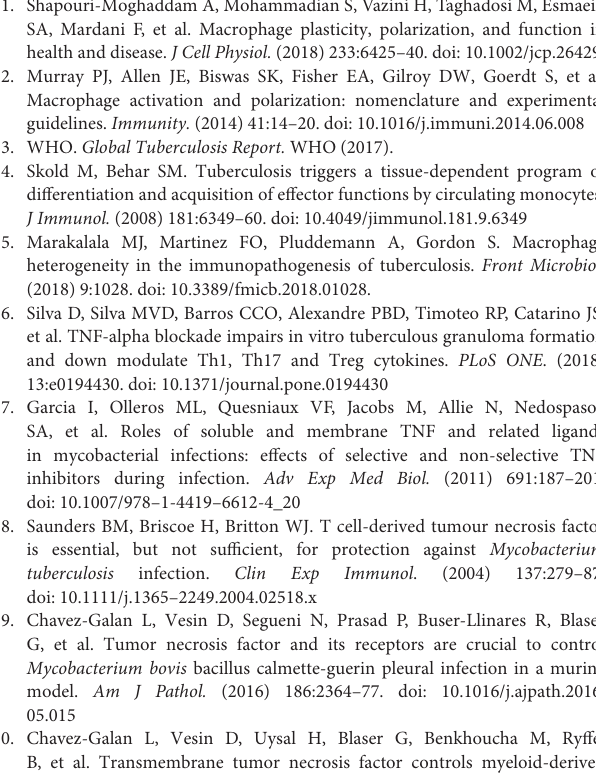
cytometry, using the Agilent RNA 6000 Pico kit, and the RNA integrity number (RIN) was obtained using an Agilent bioanalyzer to extract an algorithm that describes RNA integrity. RIN was obtained from human MDM before sorting (total MDM) (A) , and after sorting in CD3 + TCR αβ − MDM (B) and CD3 + TCR αβ + MDM (C) . The RIN value is squared in blue. The data are representative of three independent donors. Figure S3 | Analysis strategy to evaluate TNF-receptors on CD3 + CD11b + TCR αβ − and CD3 + CD11b + TCR αβ + cells after a BCG-pleural infection. A BCG-pleural infection was induced, and the cells from the pleural cavity were recovered and prepared for flow cytometry. Representative zebra plot from WT mice after 2 weeks post-infection; with adequate isotype control antibodies, the CD3 + cells were gated, and subsequently, the co-expression of CD11b and TCR αβ was identified (A) . Representative zebra plot from wild type (WT), transmembrane TNF (tmTNF KI)-expressing, and TNF knock-out (TNF KO) mice. The animals were sacrificed at 2 weeks (BCG 2w). A non-infected group (naïve) was used as the control. Inside the gate to CD3 + CD11b + TCR αβ − and CD3 + CD11b + TCR αβ + MDM, the expression of TNFR1 and TNFR2 was evaluated. The data represent four to eight animals per group from three independent experiments. Figure S4 | CD3 + TCR αβ + and CD3 + TCR αβ − MDM do not secrete anti-inflammatory cytokines by CD3- and TNF-dependent pathways. The supernatant and MDM subpopulations were recovered after 24h in culture stimulated by anti-CD3 and anti-TNF antibodies and prepared to develop a multiplex analysis. Anti-inflammatory cytokines IL-1-RA, IL-4, and IL-10 ( A–C , respectively) were evaluated using Luminex technology. The data are expressed as the mean ± SD of n = 4–6 independent donors per condition. Table S1 | Clones and flurochomes of